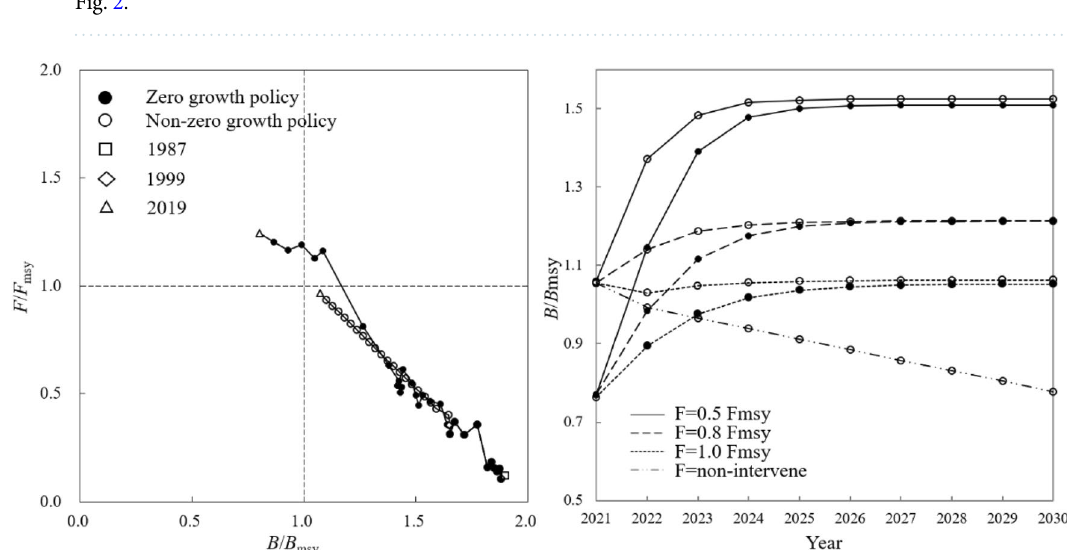
Figure 9. Rebuilding status of Portunus trituberculatus . Resource status in different quadrants following explanation in Fig.